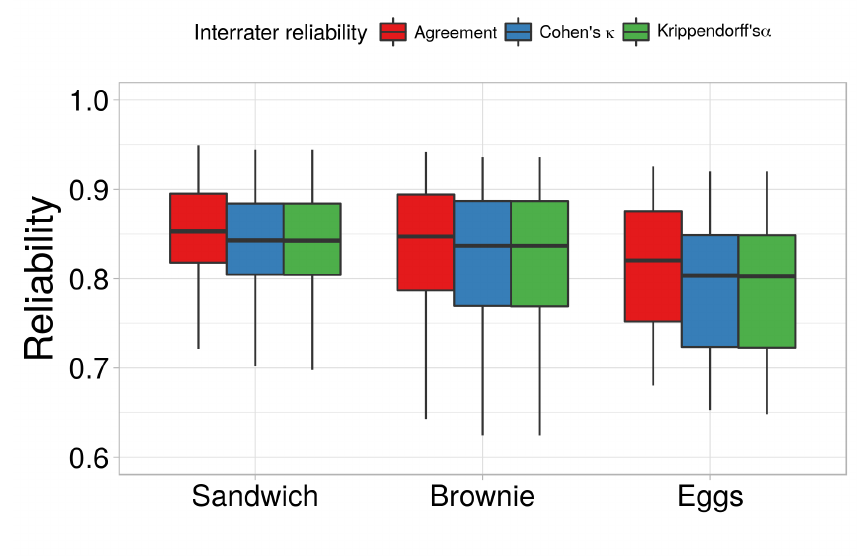
Figure 5. The median interrater reliability for the three datasets (in terms of Cohen’s κ ) and the deviation from this